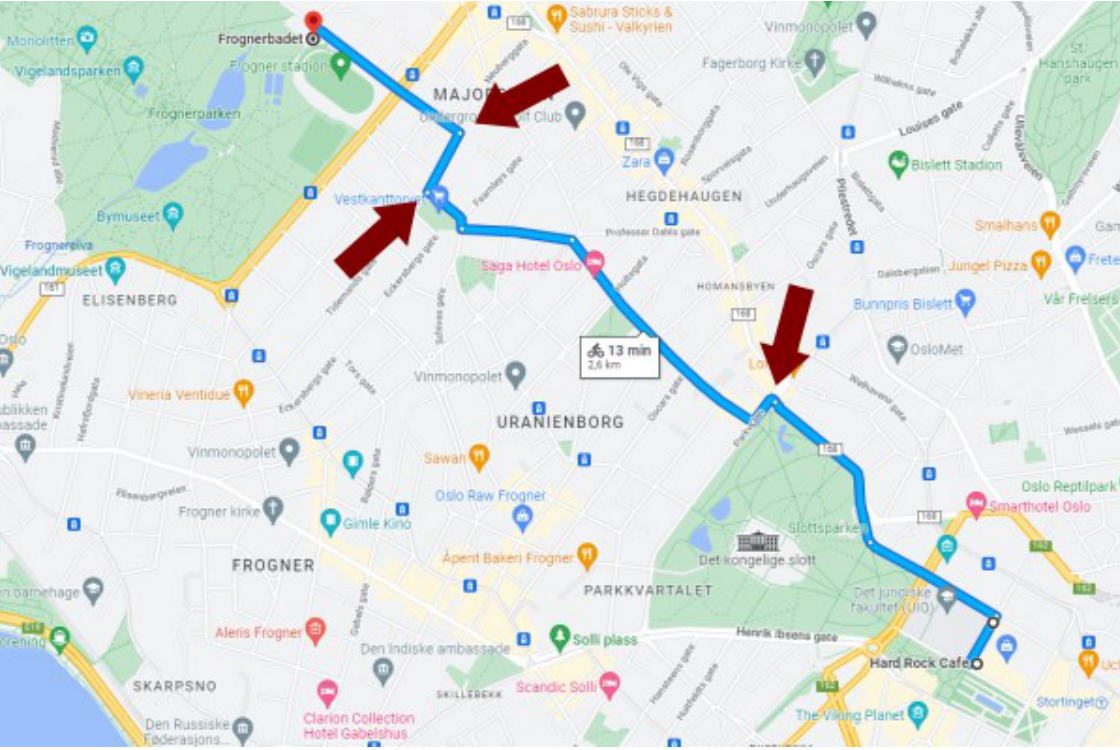
Figure 2 The cycling route through the Oslo city centre: three typical intersections where people would deviate from the route indicated with red arrows (adopted from GoogleMaps